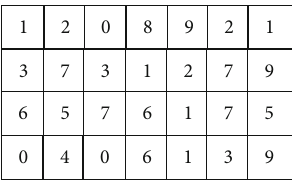
Figure 4: Image matrix